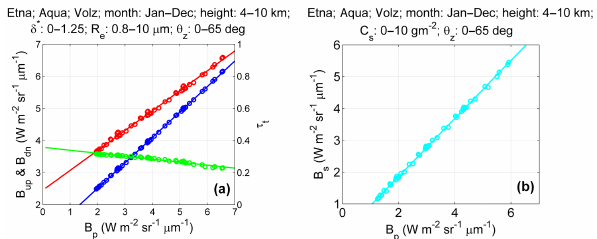
Figure 4. Linear trends of B up (red), B dn (blue), τ t (green), and B s (cyan) vs. B p for 48 different plumes (12 months and 4 heights), each obtained from a set of MODTRAN simulations.